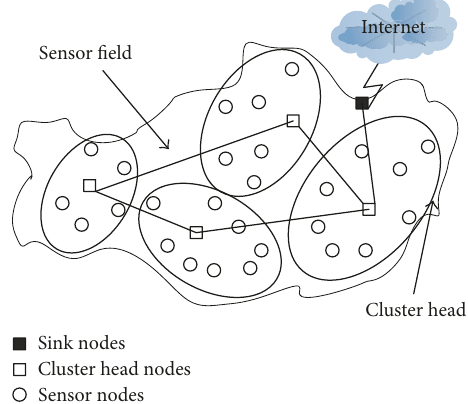
Figure 2: Network topology of wireless sensor